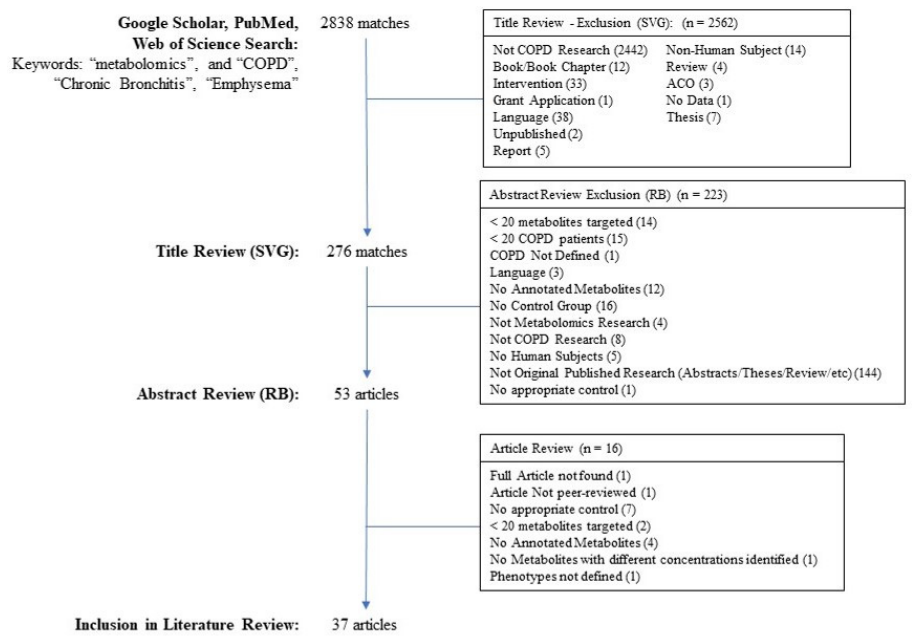
Figure 2. Inclusion/Exclusion Flowchart.